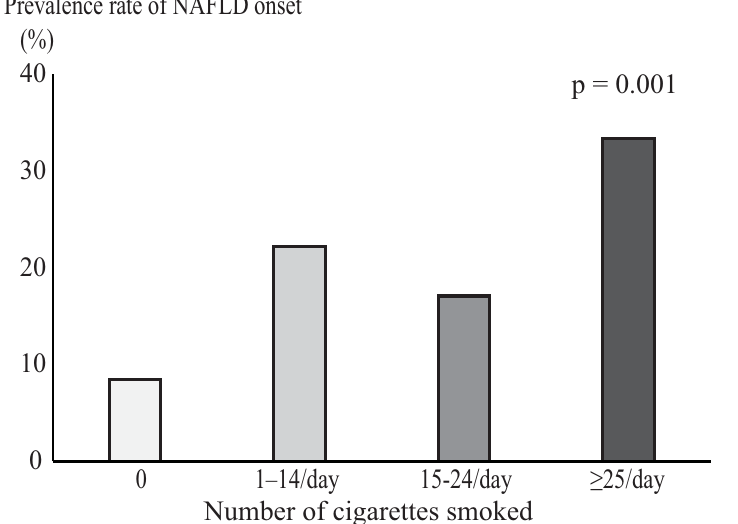
Fig 2. Association between the number of cigarettes smoked and the incidence of fatty liver disease in the nondrinker group. The p values were determined using the Cochran-Armitage test. NAFLD, nonalcoholic fatty liver